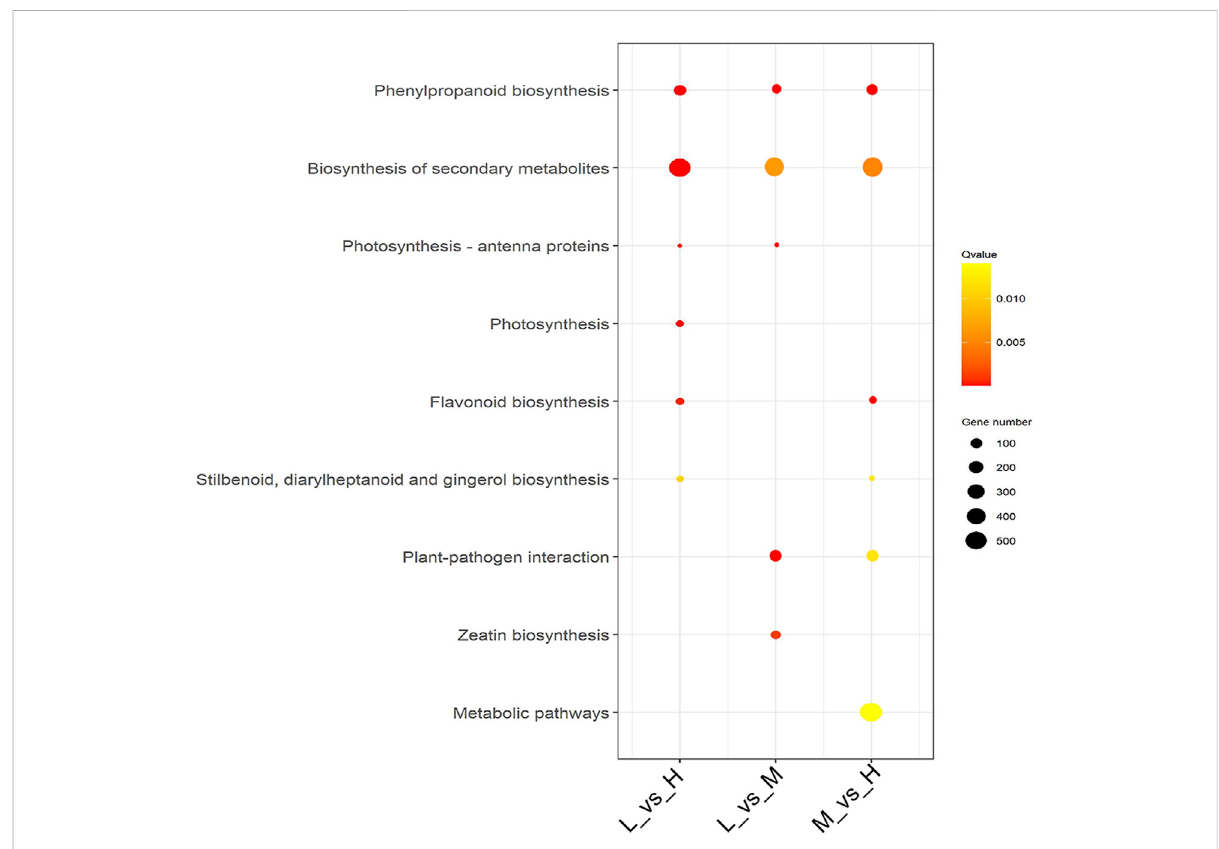
FIGURE 4 Metabolic pathway enrichment analysis of DEGs. The signi fi cance of the enrichment of the KEGG pathway is based on the student ’ s t-test, Q-value < 0.05. Analysis of the dynamic DEGs expression patterns of the three maize hybrid